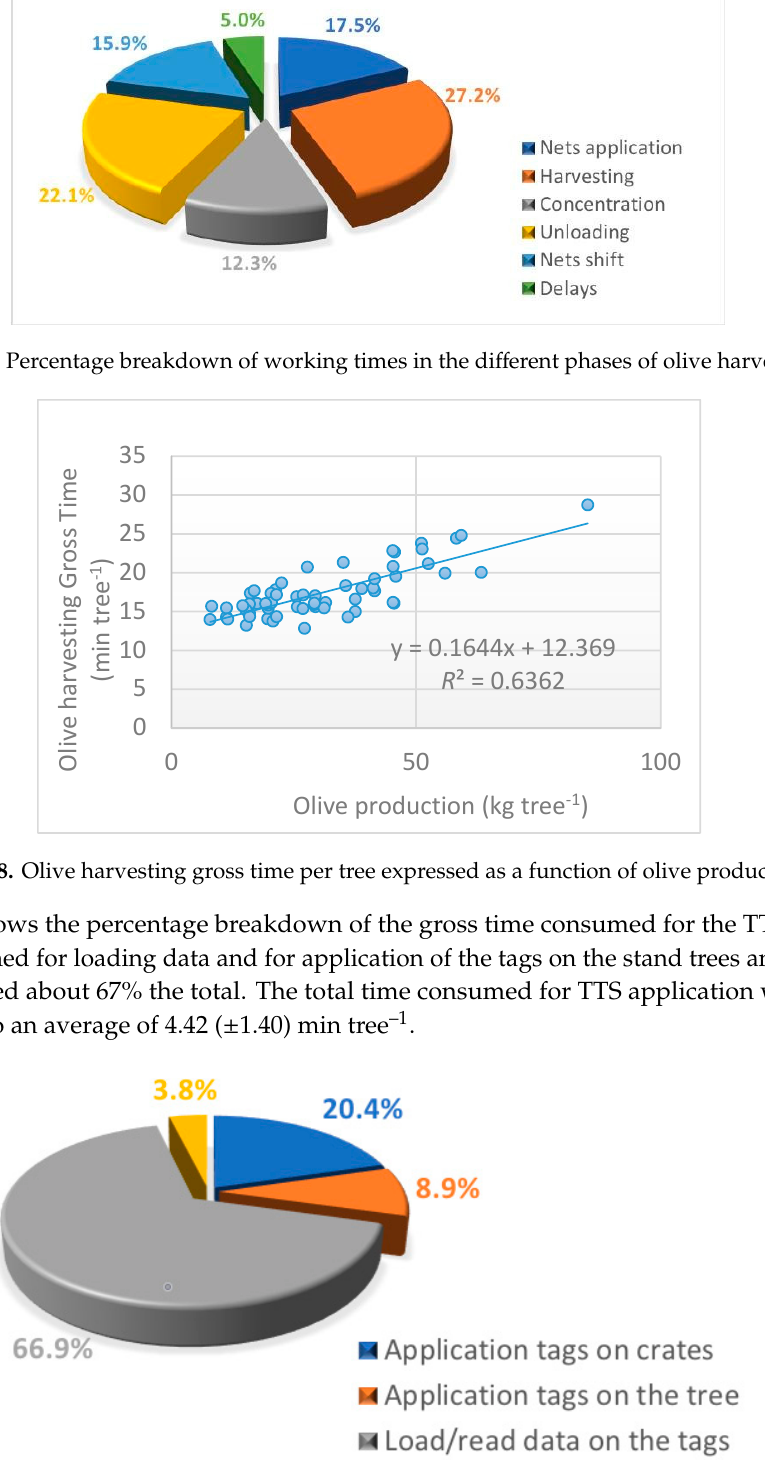
Figure 9. Percentage breakdown of the technological traceability system (TTS) application times in the different phases.